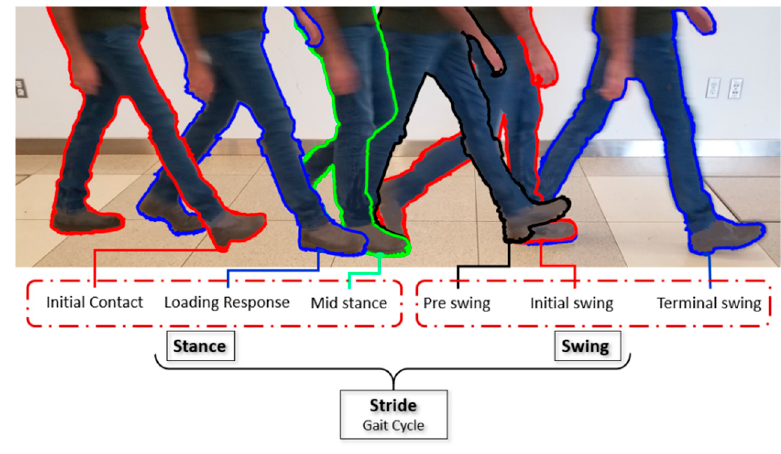
Figure 2. Human gait cycle (GC) [27].